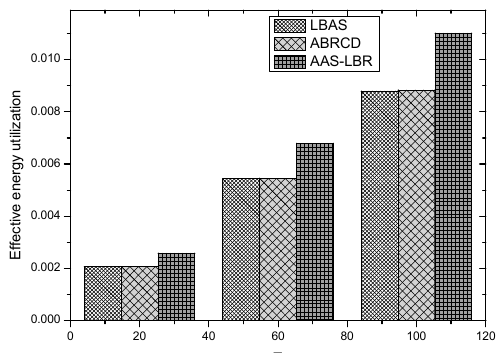
Figure 36. Effective energy utilization of three schemes under different cycles with r = 28 m.